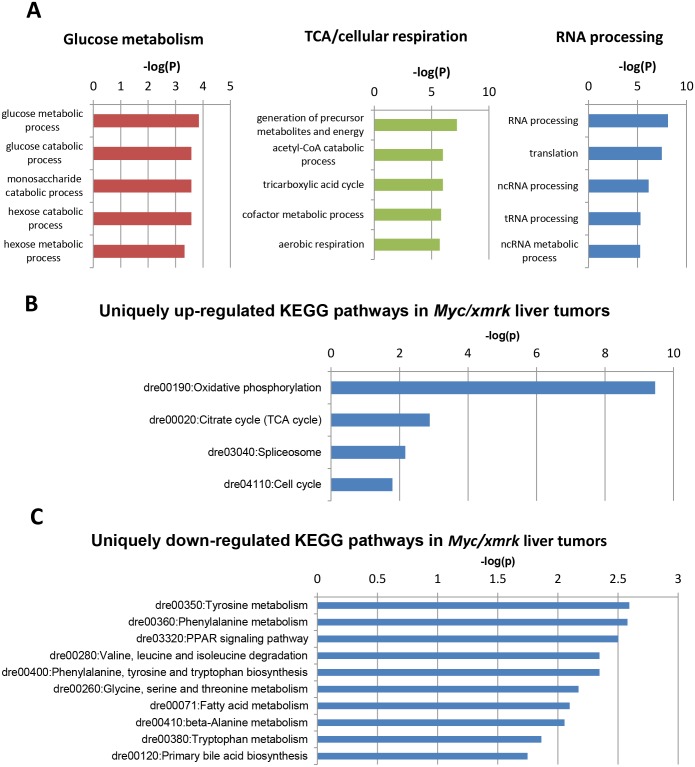
Uniquely up- and down-regulated biological process (BP) and KEGG pathways in Myc/xmrk liver tumors.Uniquely up- or down-regulated genes in the Myc/xmrk tumors (1,114 and 359 genes respectively as indicated in Fig 2B) were input into the DAVID online software and top BPs and KEGG pathways are shown. (A) Top significantly up-regulated BPs. (B) Significantly up-regulated KEGG pathway with P<0.05 and Benjamini value<0.05 cutoff. (C) Significantly down-regulated KEGG pathway with P<0.05 and Benjamini value<0.05 cutoff. Negative log P-value was plotted against different processes/pathways.